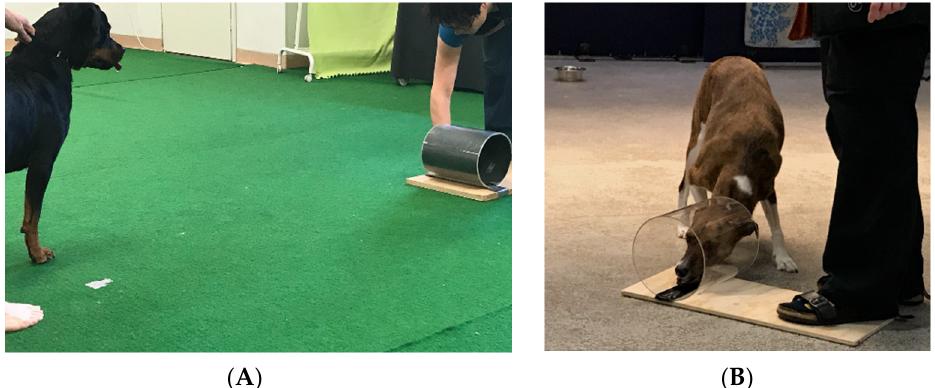
Figure 1. Test set-up for the cylinder test. ( A ) Opaque cylinder during training trials. The dog is waiting to be released before starting the trial. ( B ) Transparent cylinder during test trials. The dog is going around the transparent barrier to access the treat inside the cylinder.